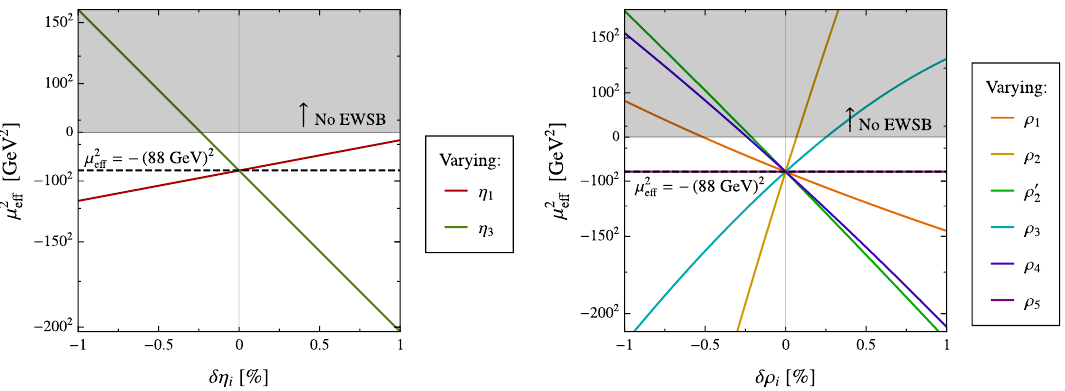
Figure 4 . Here we show the sensitivity of µ 2 deviations in the Higgs- Ω Λ = 10 3 TeV. For reference, the value of µ 2 UV by a dashed, black line. The region where µ 2